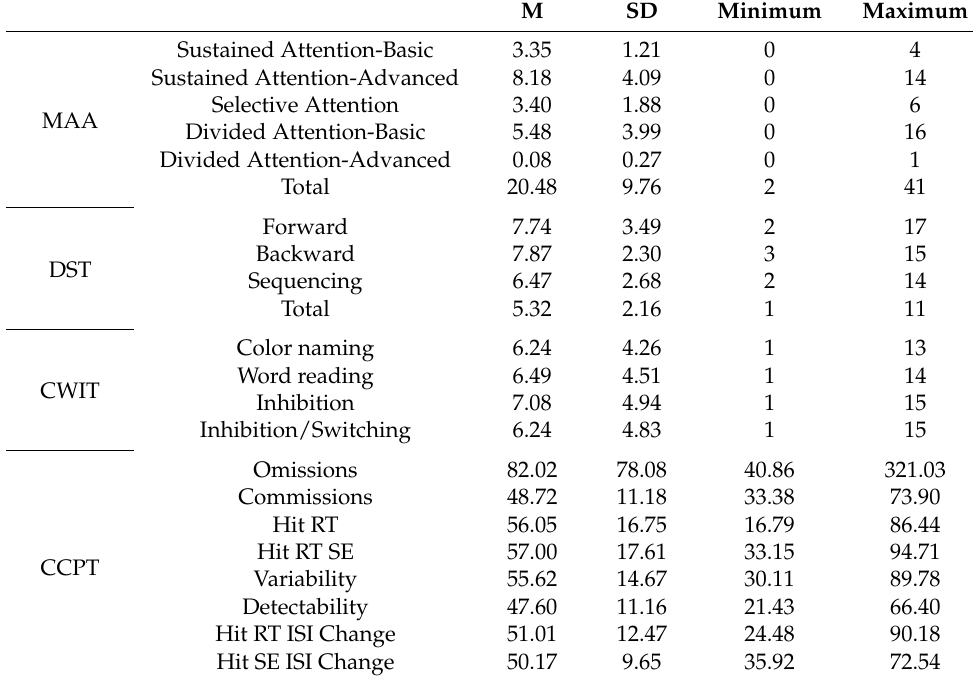
Table 3. Descriptive statistics of the MAA and neurocognitive